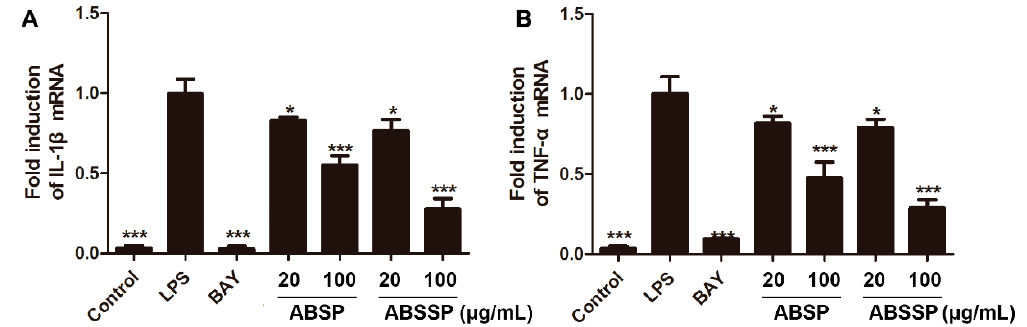
Figure 5. E ff ects of ABSP and ABSSP on the mRNA expression of IL-1 β and TNF- α in LPS-exposed RAW264.7 cells. Cells were pretreated with di ff erent concentrations of ABSP, ABSSP (20 and 100 µ g / mL), and BAY11-7082 (BAY, 5 µ M) for 2 h, and then stimulated with LPS (0.5 µ g / mL) for an additional 24 h. The mRNA levels of IL-1 β ( A ) and TNF- α ( B ) were tested by a qRT-PCR method. GAPDH was used as an internal control. Data are expressed as mean ± SD, n = 3. * p < 0.05, ** p < 0.01, *** p < 0.001, compared with LPS.